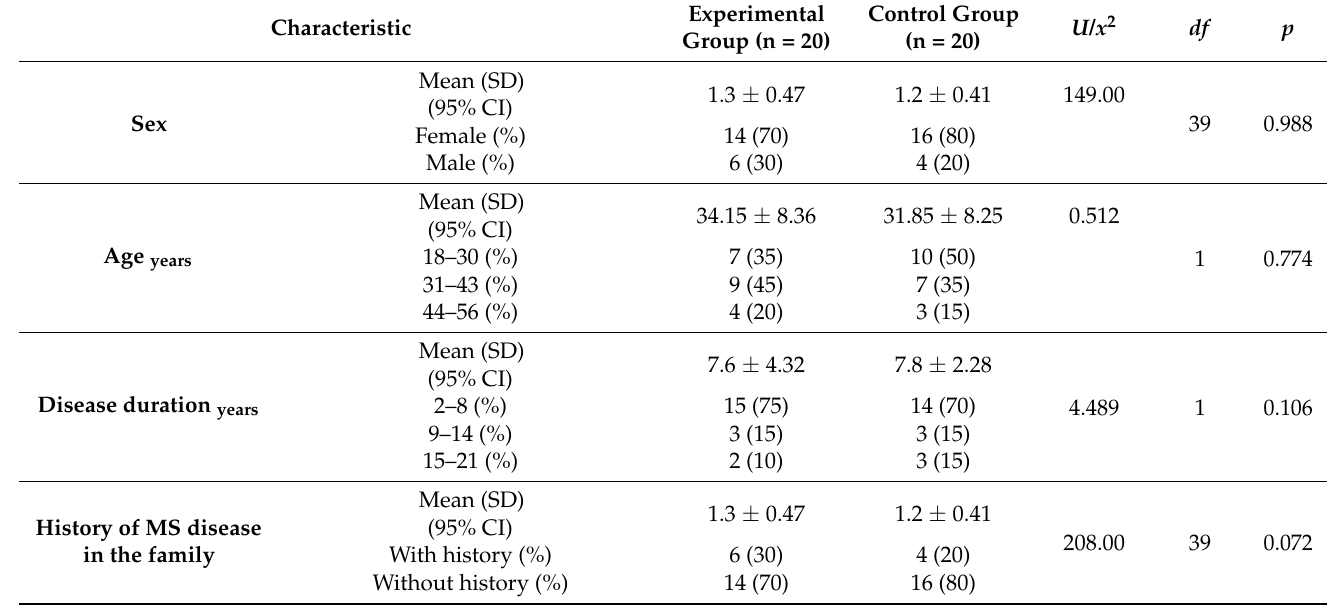
Table 1. Demographic and clinical characteristics of the experimental and control